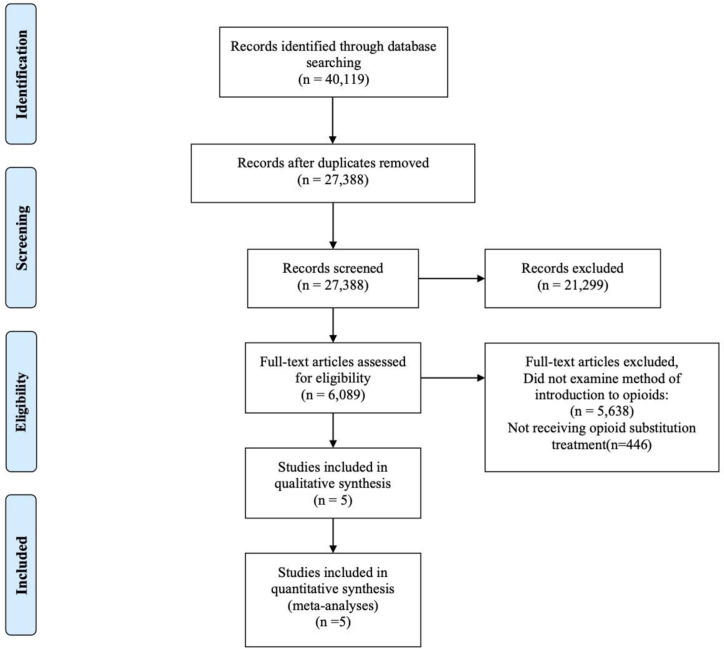
PRISMA Flow Diagram.